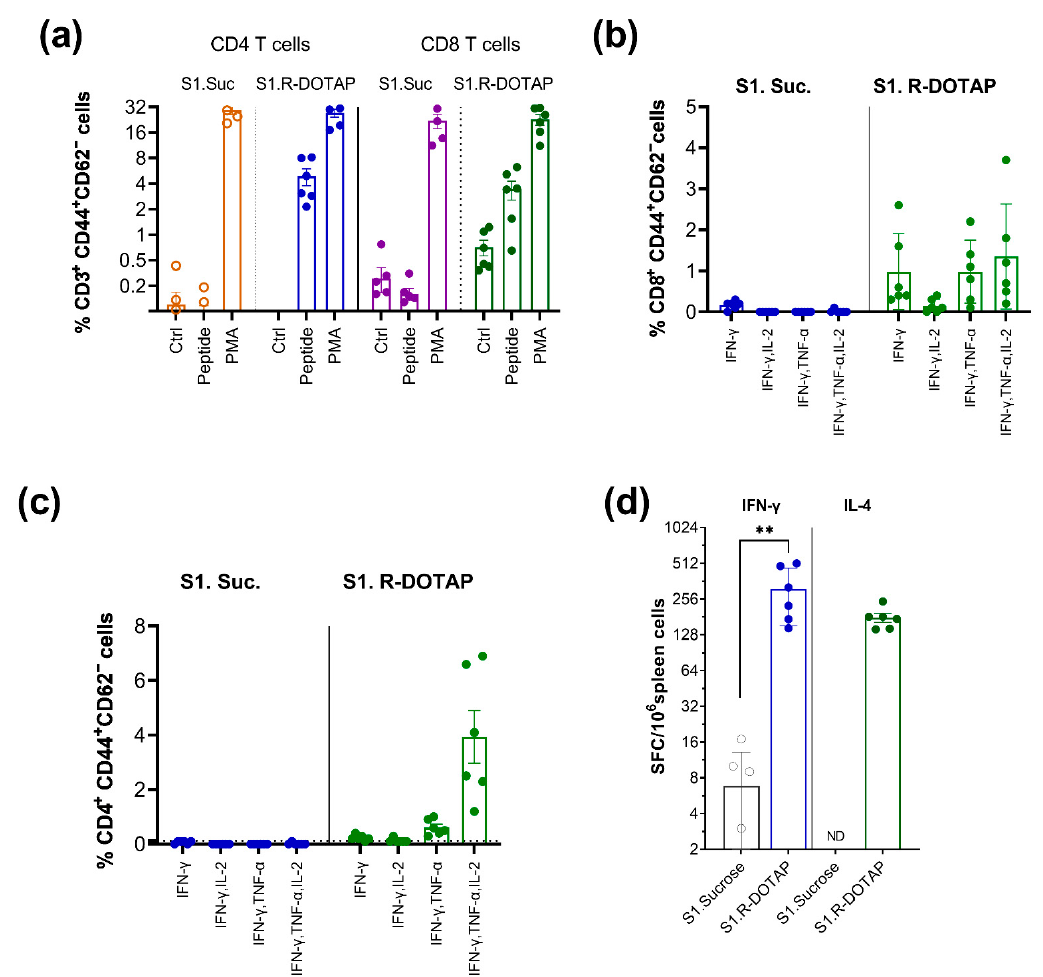
Figure 5. R-DOTAP-containing vaccine formulations induced polyfunctional T cells and long-term memory T-cells responses. Groups ( a – c ) of C57Bl/6J ( n = 5) mice were subcutaneously injected on day 0 and day 21 with vaccine formulations containing 10 μ g/dose spike S1 domain (S1), formulated with R-DOTAP nanoparticles (S1. R-DOTAP) or sucrose buffer (S1.Suc). Splenocytes isolated 7 days after second vaccine were stimulated overnight with spike S1 CD8 epitope (VL8) and CD4 epitope (VT15). Effector T cells (CD3 + , CD44 + , CD62L − ) in spleen ( a ) producing IFN- γ in response to peptide stimulation (peptide) or PMA/ionomycin (PMA) or no stimulation (Ctrl) were measured cells using intracellular cytokine staining assay. ( b , c ) Polyfunctional CD8 T cells ( b ) and CD4 T cells ( c ) pro- ducing IFN- γ , IL-2 and TNF-alpha among gated (Figure S3) IFN- γ –producing effector cells ( a ) in spleen from vaccinated mice. Data represent mean ± SEM percentage of cytokine producing cells from each group. Groups ( d ) of BALB/cJ ( n = 5) mice were immunized intramuscularly on day 0 and day 28 with 50 μ L of vaccine formulations containing 10 μ g/dose spike S1 domain formulated with R-DOTAP nanoparticles (S1.R-DOTAP) or sucrose buffer (S1. Sucrose). T–cell memory responses were measured 28 days after second dose (56 days total) by stimulation of spleen cells overnight